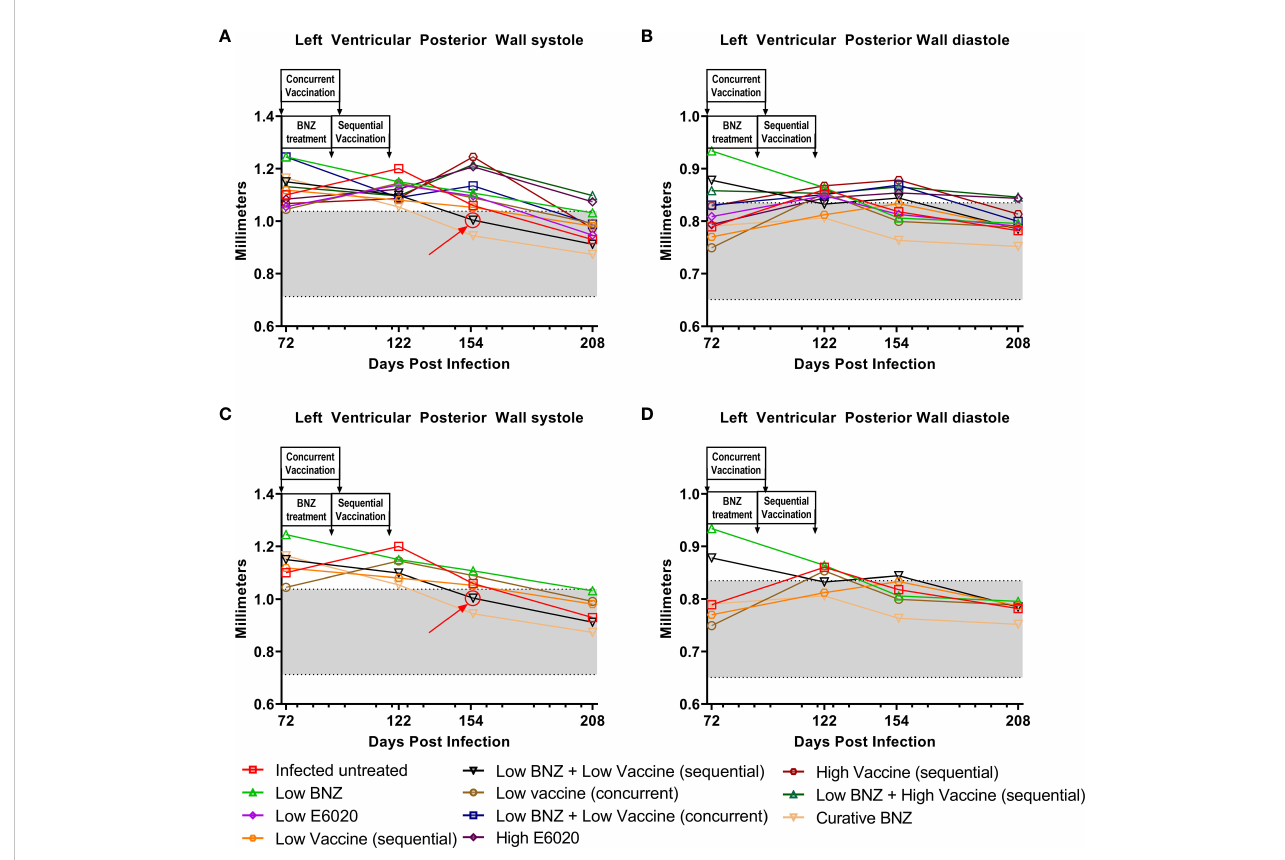
FIGURE 3 Left ventricular posterior wall thickness (LVPW) after treatment. M-mode images from echocardiographic examination were used to measure LVPW in infected untreated and treated mice at 70dpi, 122dpi, 154dpi and 208dpi during both systole (A) and diastole (B) . Panels (C) and (D) illustrate only a subset of treatment groups to better visualize treatment differences between key groups. The grey shaded area represents the mean ± SD of the LVPWs and LVPWd measurement from naïve age matched